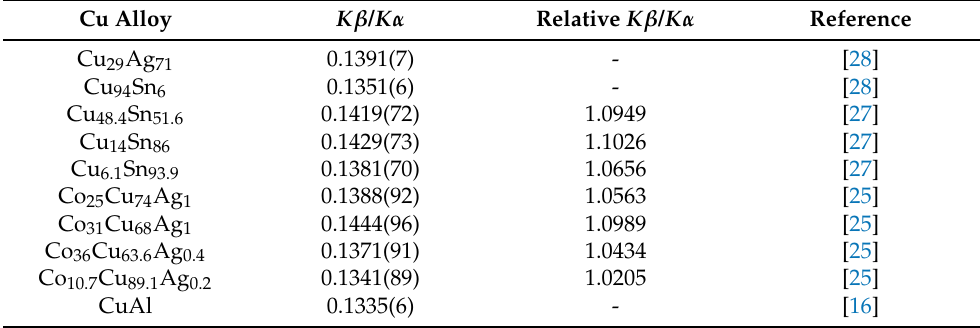
Table 5. K β / K α intensity ratio and relative K β / K α ratio (compared to K β / K α ratio of pure Cu) for copper alloys taken from